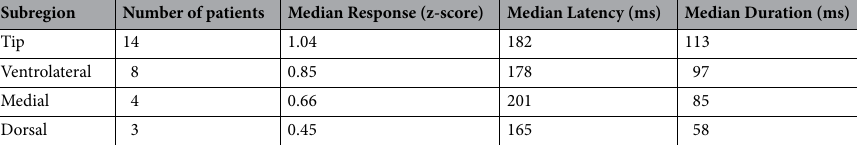
Table 1. Median (across patients) response properties of four